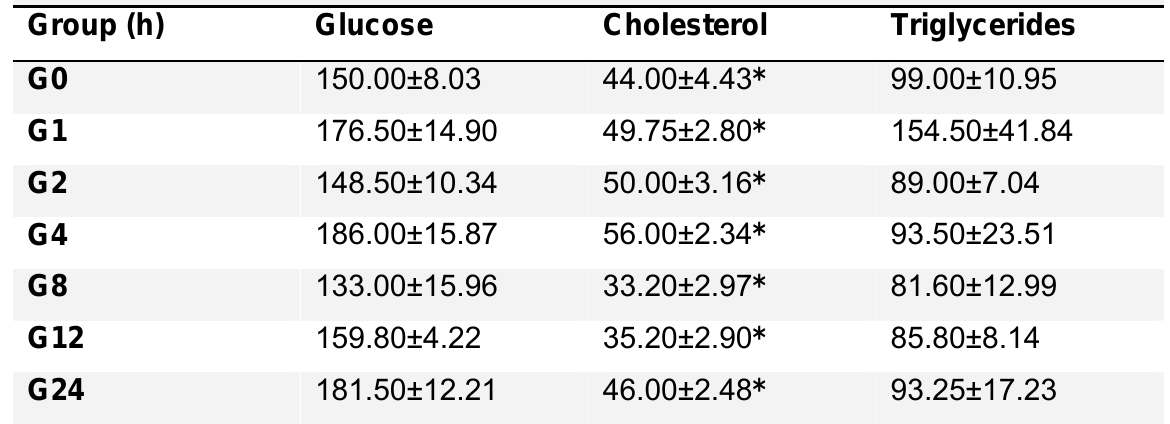
Table 4. Effects of a single sc injection of Androctonus crassicauda venom on the levels of serum alanine aminotransferase (ALT; U/l), aspartate aminotransferase (AST; U/l), alkaline phosphatase (ALP; U/l), gamma-glutamyl transferase (GGT; U/l), and lactate dehydrogenase (LDH; U/l) in rats at the 1 st (G1), 2 nd (G2), 4 th (G4), 8 th (G8), 12 th (G12), and 24 th (G24) hours after venom injection. Results are presented as the mean±S.E.